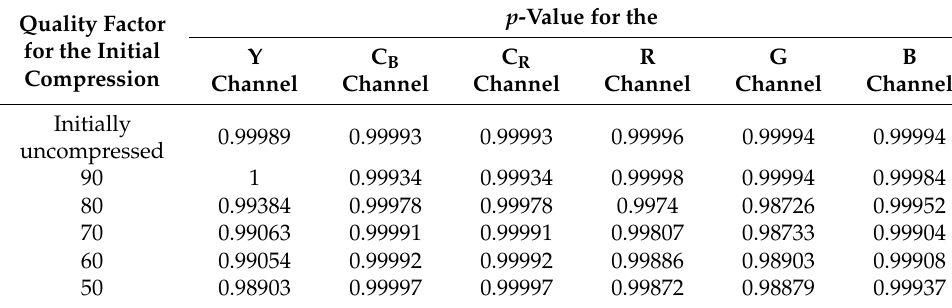
Table 2. Comparison between DCT coefficients and the NBL.